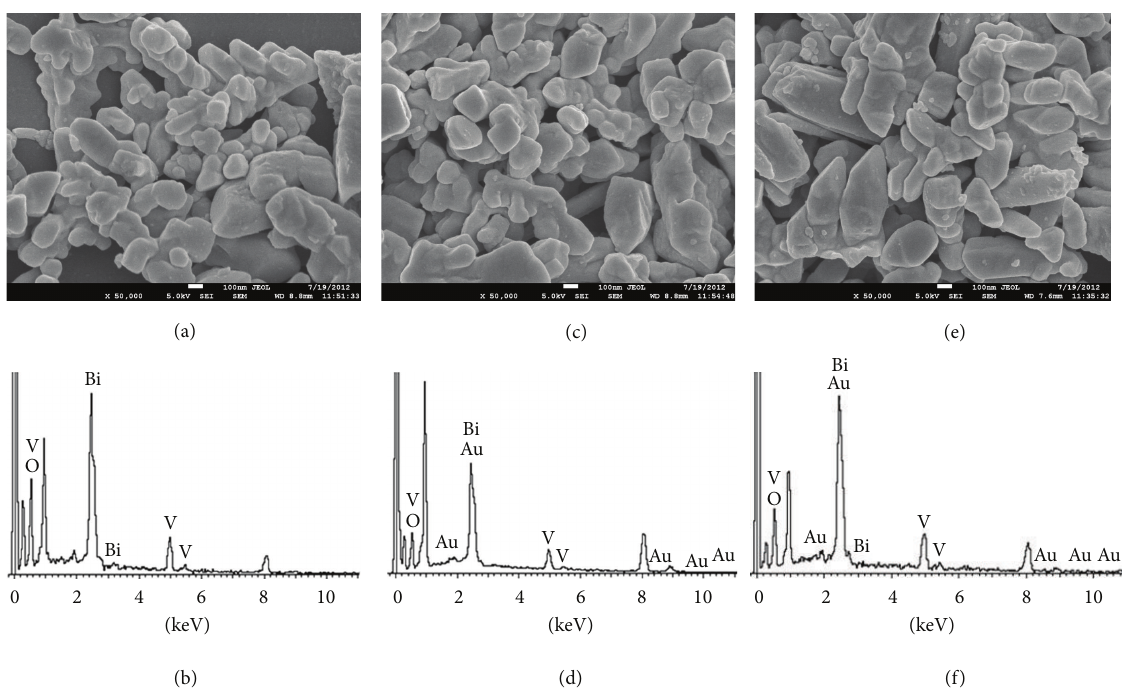
Figure 2: SEM images and EDX spectra of (a)-(b) pure BiVO 4 , (c)-(d) 0.25 mol% Au/BiVO 4 , and (e)-(f) 1.0mol% Au/BiVO 4 samples, respectively.